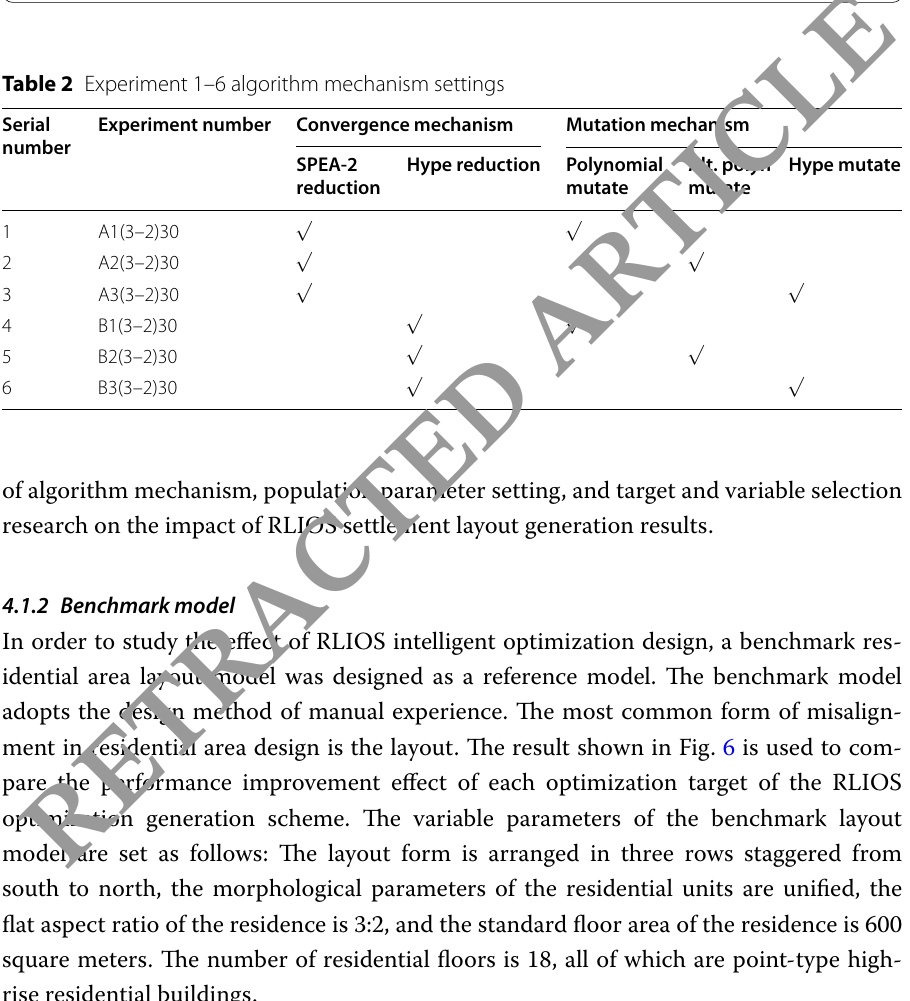
Fig. 6 Baseline residential layout model